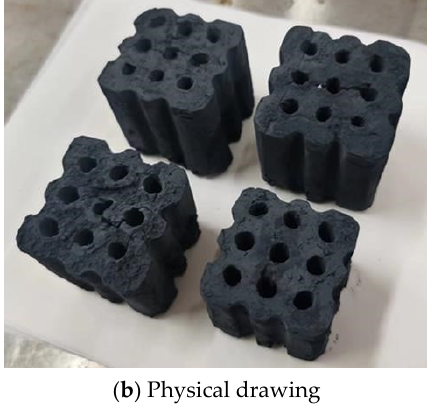
Figure 1. Cobalt-oxide honeycomb structure.